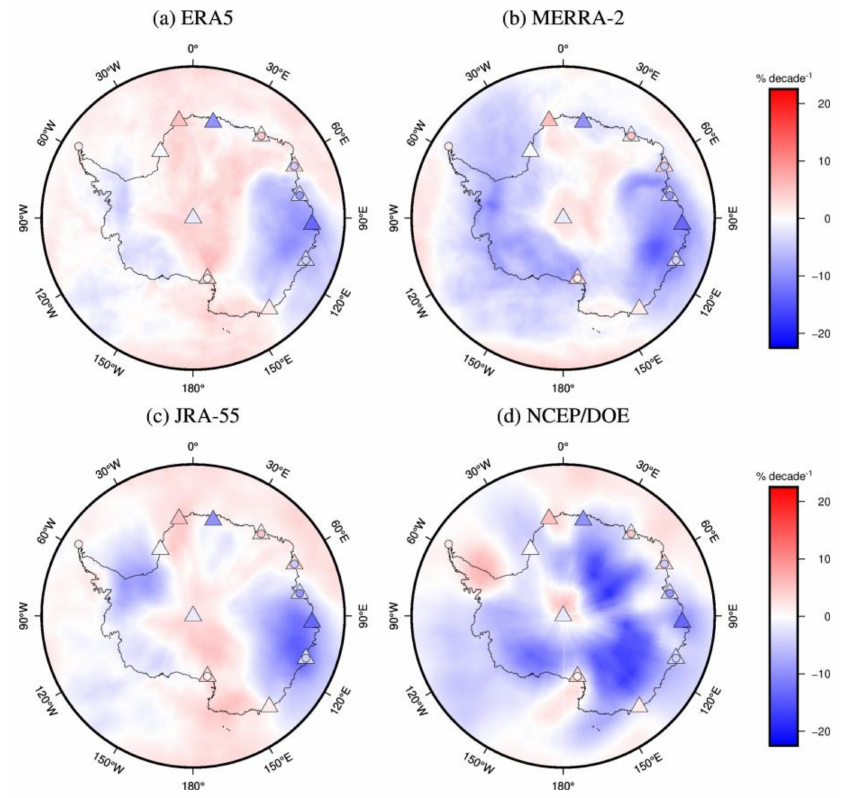
Figure 14. Relative PWV trends over Antarctica for 2001 to 2018 derived from ( a ) ERA5, ( b ) MERRA-2, ( c ) JRA-55, ( d ) NCEP/DOE reanalysis (color shading), GNSS (color circles) and radiosonde (color